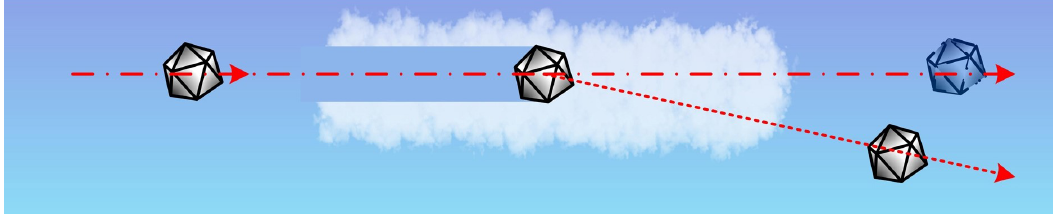
Figure 3. Soft deceleration of space debris using a cloud of micrometer-scale dust